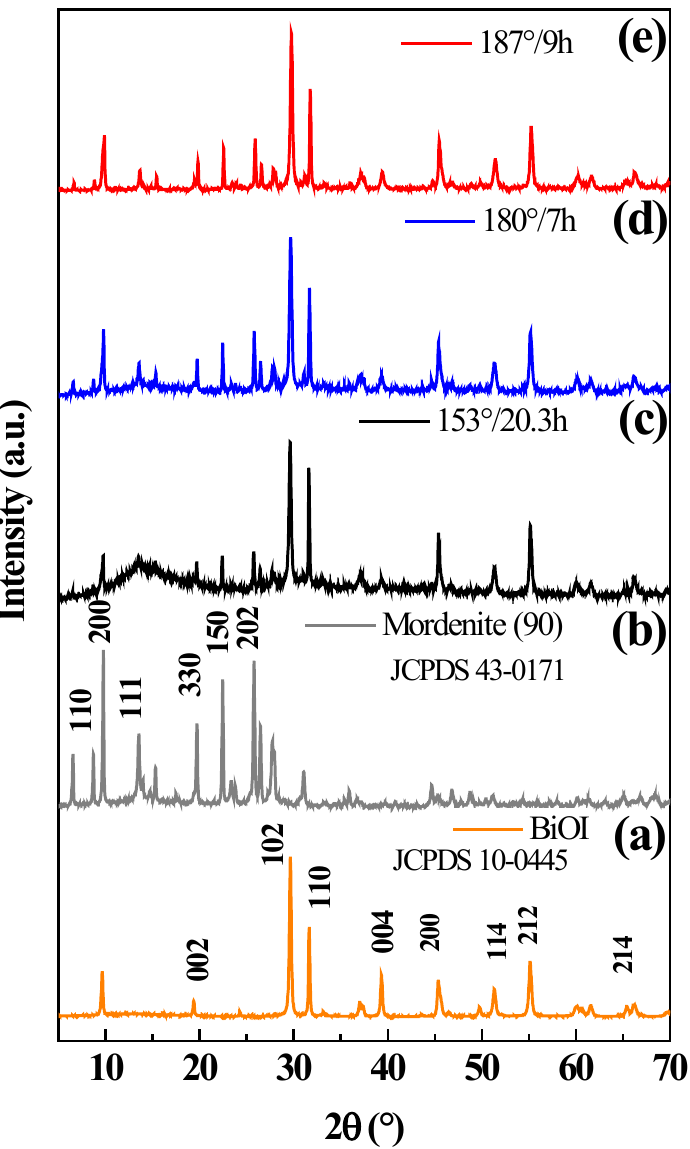
Figure 6. X-ray diffraction patterns of synthesized materials: ( a ) pure BiOI, ( b ) mordenite, ( c ) BiOI/mordenite composite synthesized at 153 ◦ C during 20.3 h, ( d ) BiOI/mordenite composite obtained at 180 ◦ C during 7 h, ( e ) optimized BiOI/mordenite composite synthesized at 187 ◦ C during 9 h. The SEM micrographs in Figure 7 display single BiOI (a), single mordenite zeolite (b), and BiOI/mordenite composites synthesized at different time and temperature conditions (c, d, and located at 2θ 19.4°, 29.6°, 31.6°, 39.4°, 45.4°, 51.3°, 55.3°, and 66.3°, which are attributed to